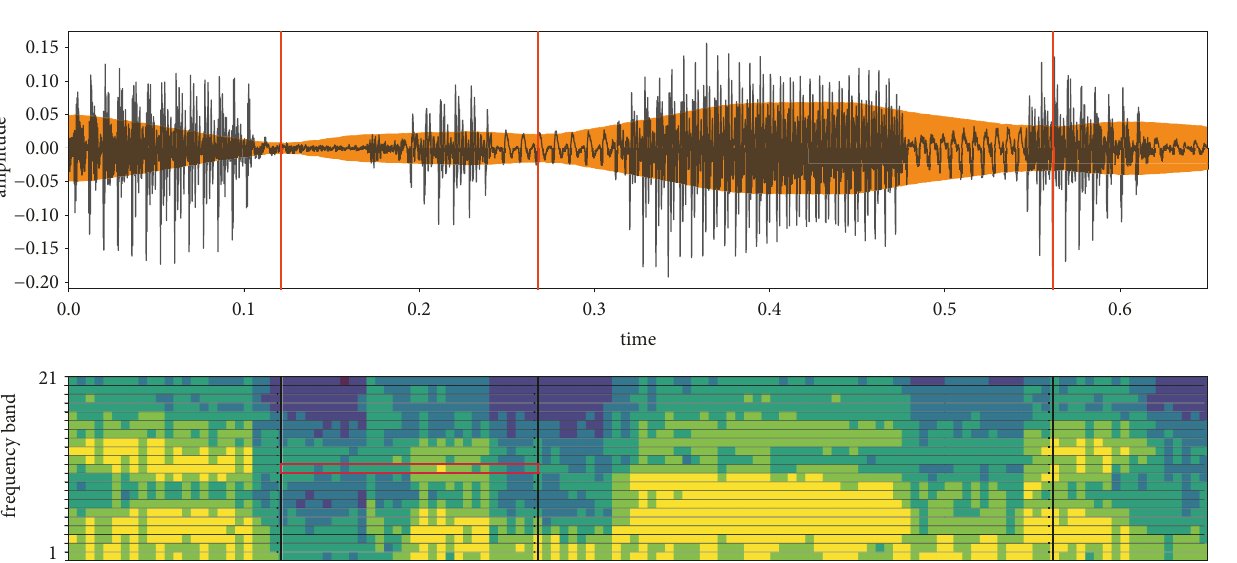
Figure 8: Oscillogram of the speech signal for a realization of the word economic with Hilbert envelope (in orange) outlining the signal is shown on the top panel. The lower panel depicts the discretized MEL scaled spectrum of the signal. The vertical bars are the boundary points that partition the signal into 4 chunks. For one chunk, horizontal lines (in red) highlight one of the frequency bands for which the FBSFs provide summaries of the variation over time in that frequency band. The FBSF for the highlighted band is “band11-start3-median3-min2-